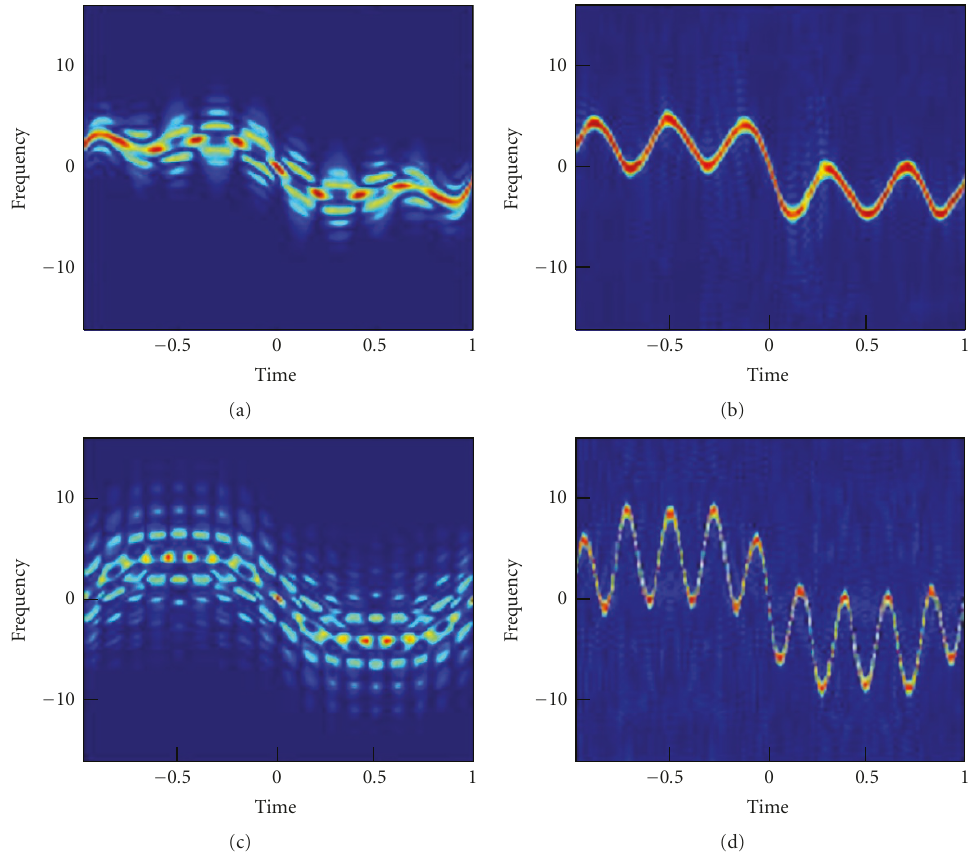
Figure 21: TFDs of test signals, (a), (b) a noisy signal, SNR = 10dB: (a) WD, and (b) sixth GCAD, (c), (d) a signal with fast-varying IF: (c) WD, and (d) sixth GCAD (all adopted from Cornu et al.